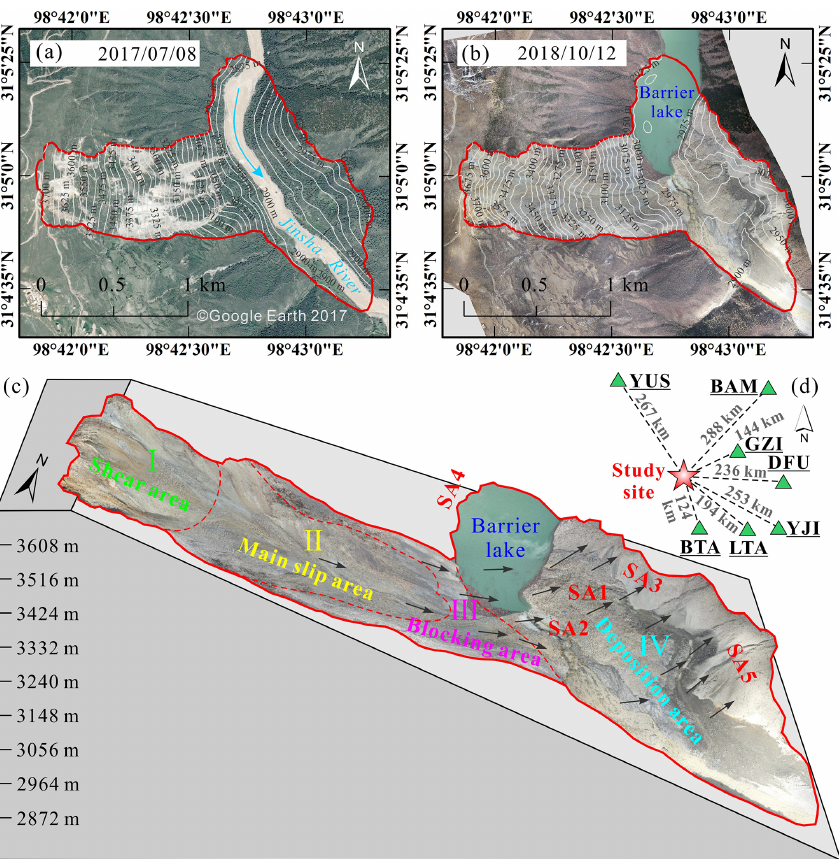
Figure 1. Location of the study area. (a) Digital orthophoto map (DOM) of the Baige landslide area in 2017, (b) DOM of Baige landslide after the 2018 event, (c) schematic cross section with remote sensing overlay showing key features of the Baige landslide (SA1 and SA2 are the two main accumulation zones, the debris of SA1 is mainly from the shear area, while that of SA2 is mainly from the main slip area and blocking area; SA3 is the left bank of the river, scoured by landslide debris; SA4 is a small area of the right bank scoured by landslide debris; SA5 is the downstream left bank, which is affected by the landslide body mix with the sandblasting water), and (d) location of the Baige landslide (red star) relative to seismic stations (green triangles) used in the study. The remote sensing image map data of (a) is from the © Google Earth 2017, and the data of (b) and (c) are from the authors’ own uncrewed aerial vehicle (UAV) photography measurements.